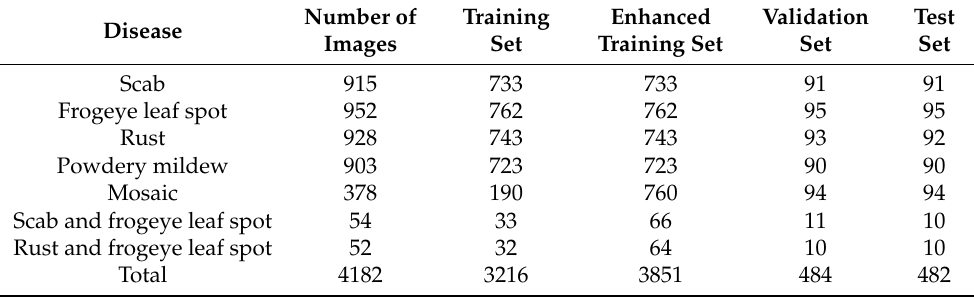
Table 1. Numbers of the training set, validation set, and testing set.